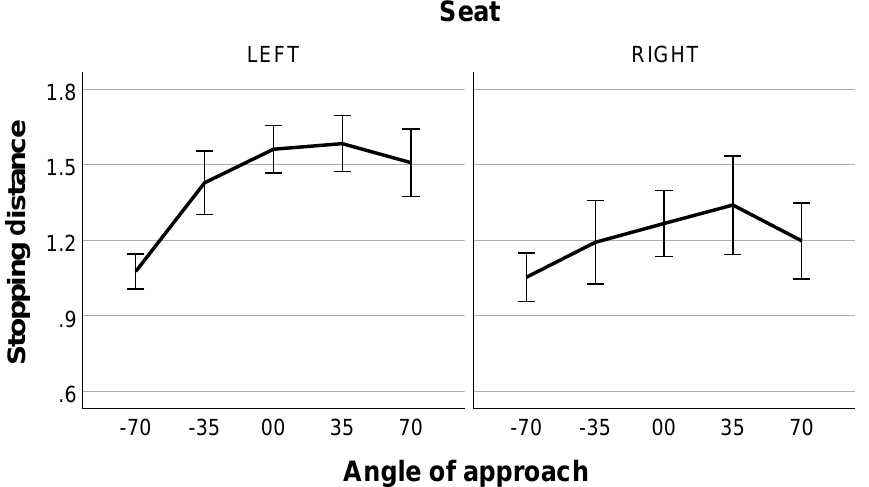
Figure 6. Average stopping distance (in meters) per angle of approach (ranging from − 70 ◦ to + 70 ◦ ) and seat in study 2: Whiskers represent 95% confidence